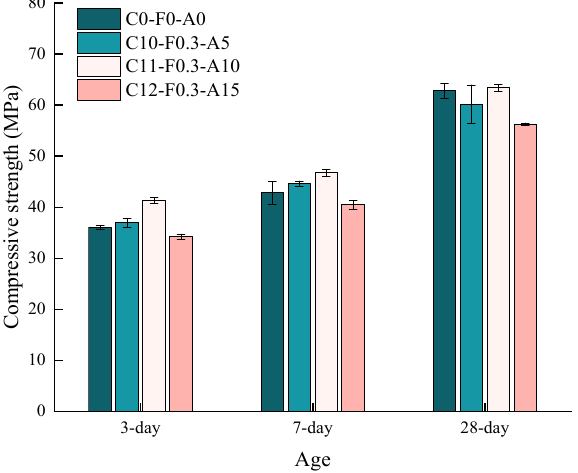
Figure 9. Effect of synergistic action of YDF and YDA on the compressive strength of cementitious mortars.